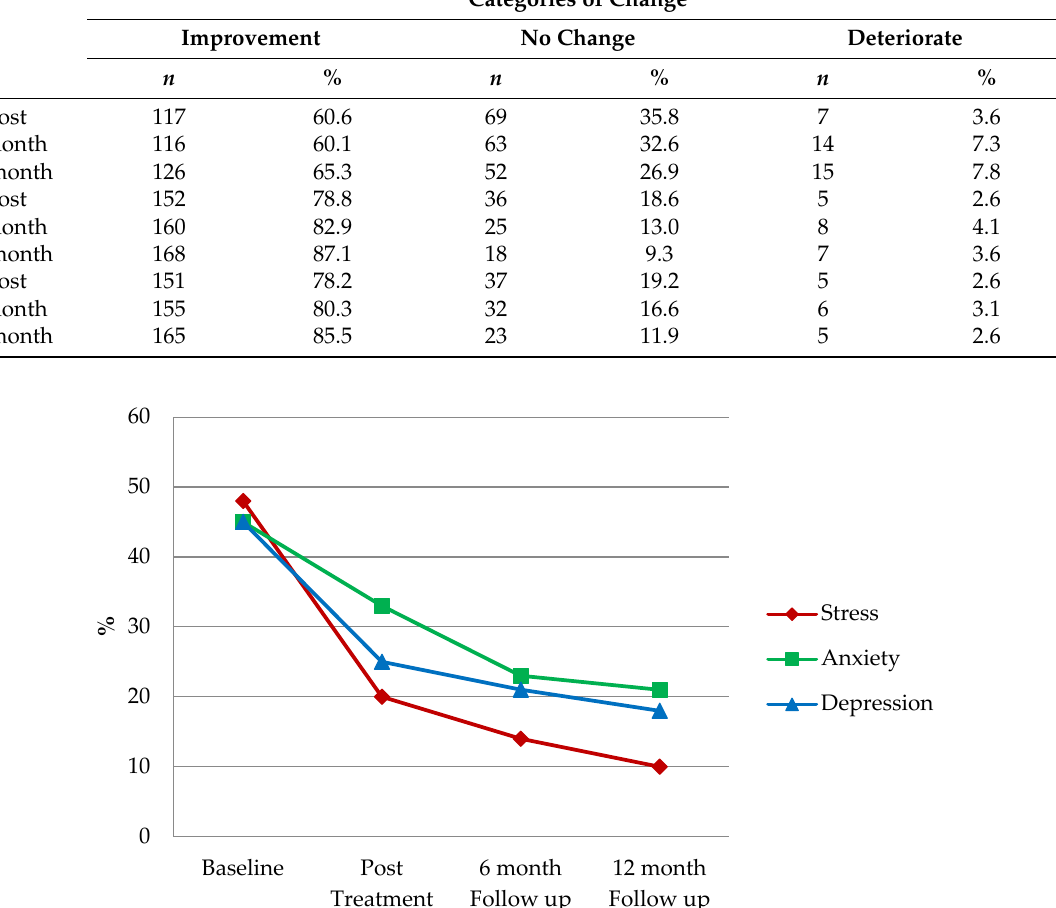
Figure 2. % of caregivers who reported DASS in clinical range at baseline, post-treatment, 6-month and 12 month follow-up ( n = 193).